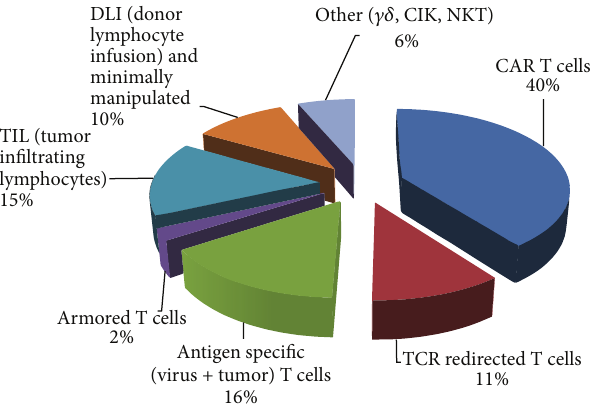
Figure 2: Open clinical studies investigating the safety and effi- ciency of adoptive T cell therapy (ATC) in cancer registered in https://clinicaltrials.gov/ as of December 2015 (search terms: “inter- vention: T cells”, indication: “cancer”). More than 200 protocols are registered, and about 40% of these address the use of CAR T cells, of which 65% are studied in trials for hematological malignancies. The use of unmodified/minimally manipulated/nongene modified T cells (based on the endogenous T cell repertoire) isolated from PMBC and from tumor (TILs) constitutes a similar fraction (16% virus/antigenspecific+15%TIL+10%DLI/minimallymanipulated) to CAR T cells. TCR gene modified T cells make-up about 11% of the studies. The term armored T cells refers to the adoptive transfer of T cells that have been precoated ex vivo with bispecific antibodies targeting CD3 and tumor associated antigen, like CD19